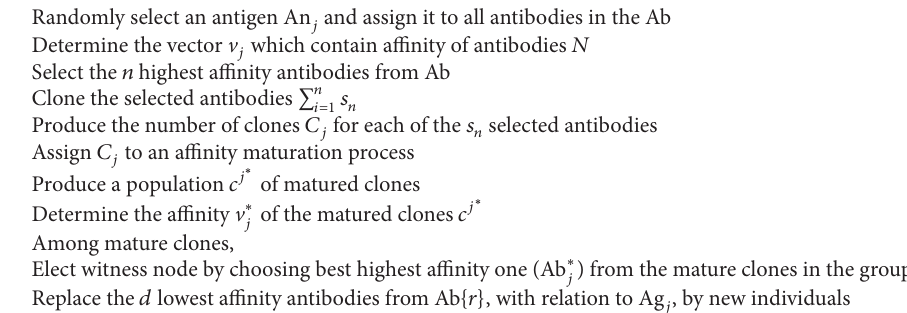
Algorithm 1: Selection of witness